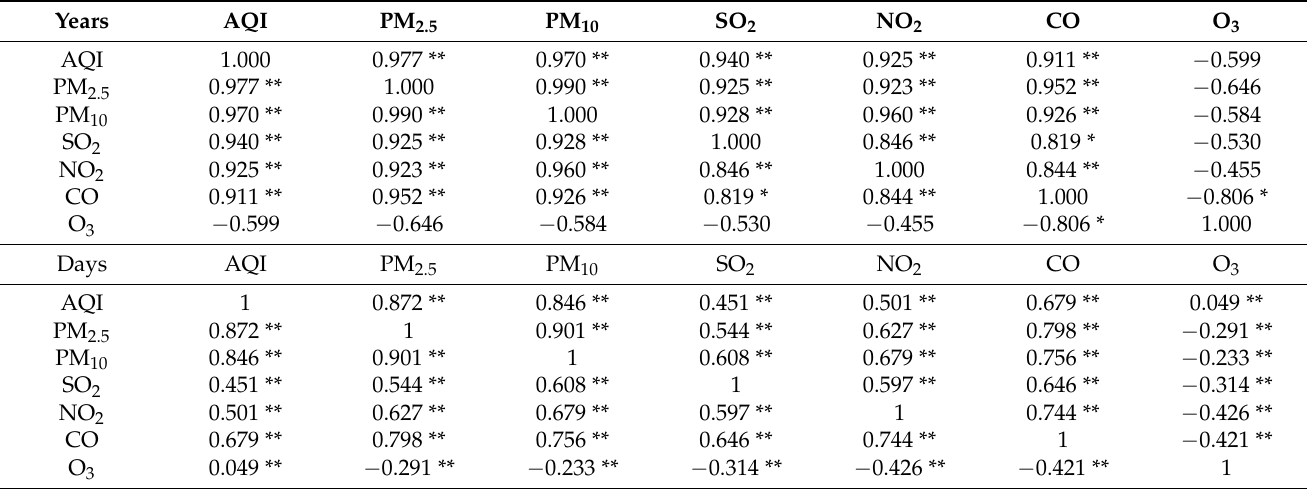
Table 3. R between six air pollutant and AQI